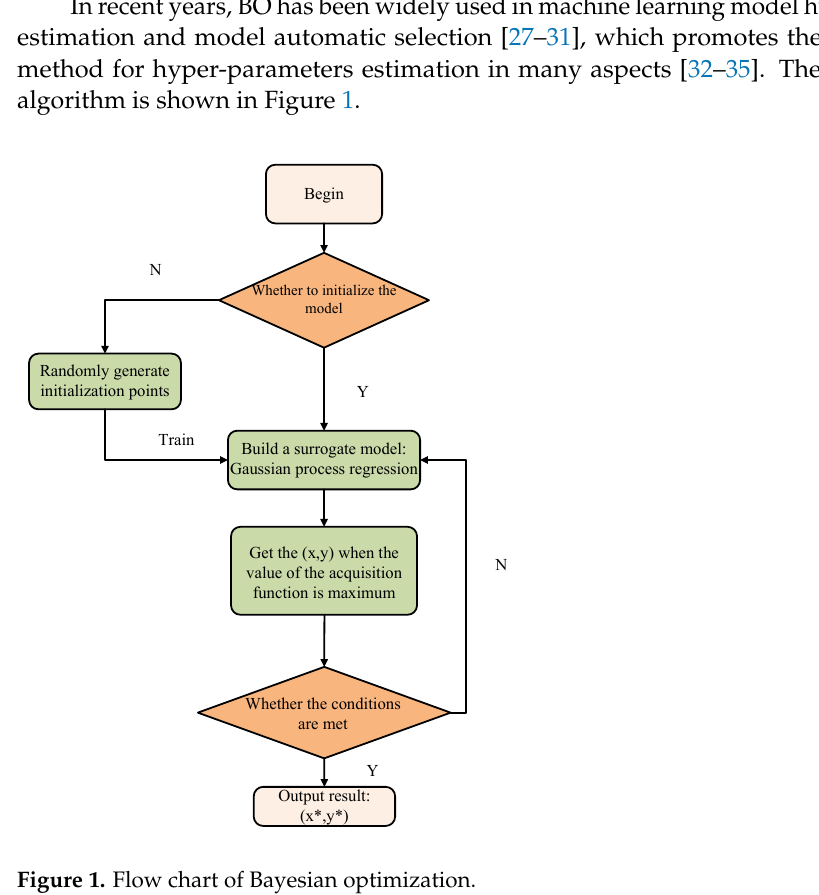
Figure 1. Flow chart of Bayesian